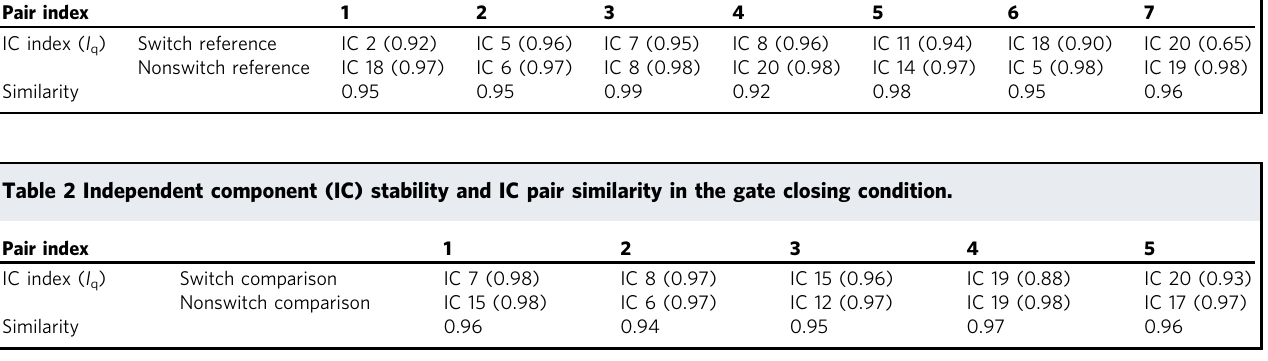
than with fewer for all conditions. As shown in Supplementary Fig. 2, the 20 clusters that show the best clustering quality had the lowest values of R-indices in all four conditions (i.e.,